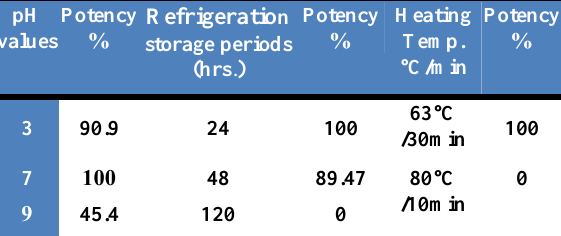
Table, 2: The effect of different pH values, refrigeration storage periods and temperature of heating on the antibacterial activity of nisin 30